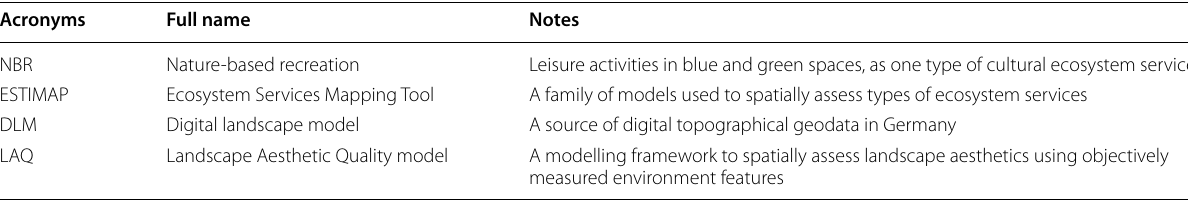
Table 1 List of abbreviations used in this